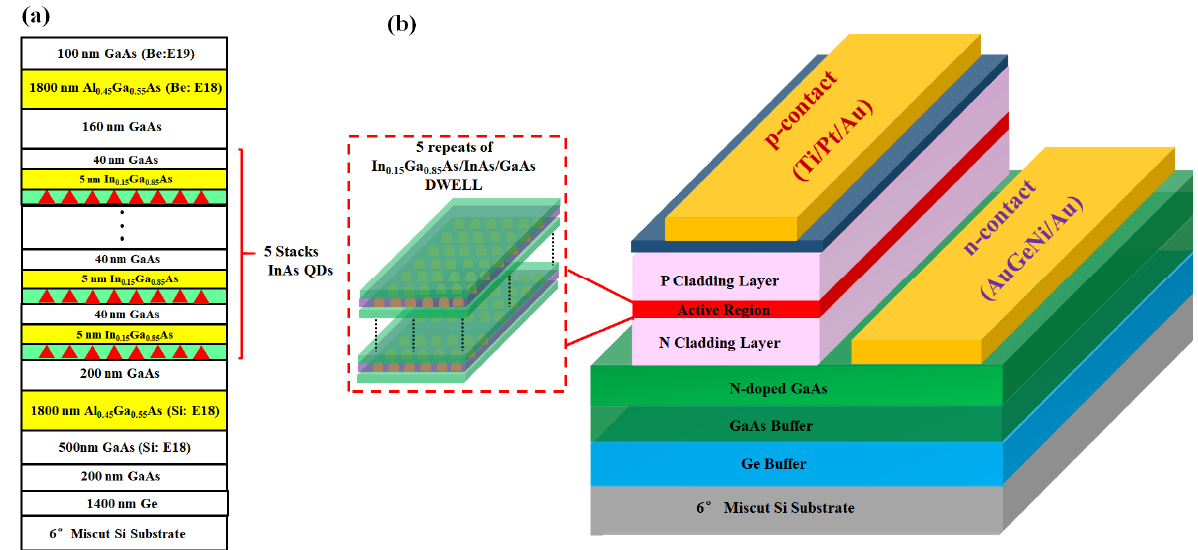
Figure 2. Schematic of: ( a ) the structural growth of InAs/GaAs QDs ( b ) the processed InAs/GaAs QD laser with coplanar electrodes on 6° miscut Si (not to scale) .